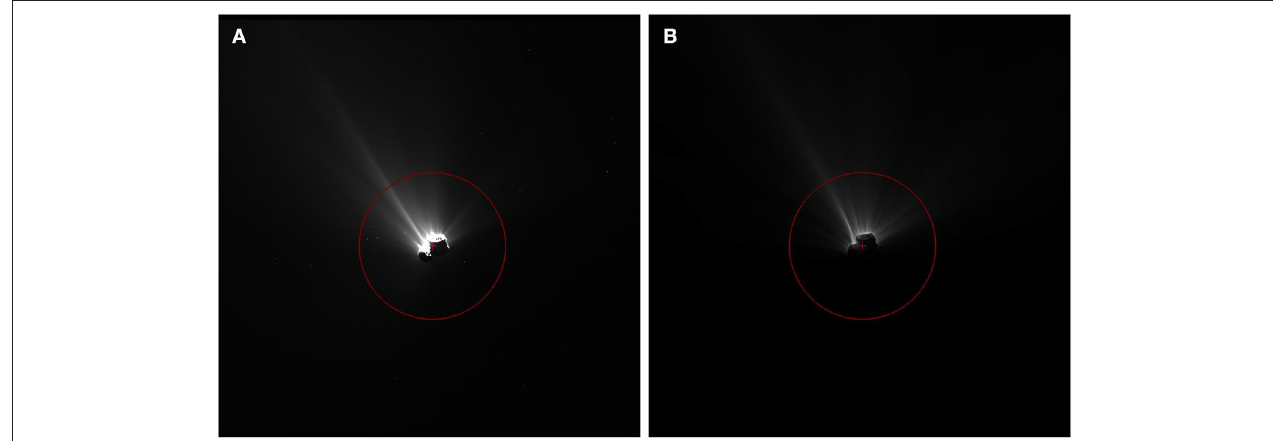
FIGURE 5 | Panel (A) shows the OSIRIS image WAC_2015-08-09T09.13.16.574Z of epoch 12 (solstice) with an enhanced contrast to show the dust coma. Panel (B) shows the synthetic image with power-law exponent of q = 4 of our dust model. The crosses in each panel indicate the center of the nucleus and the red circles indicate an impact parameter distance of b = 11 km.